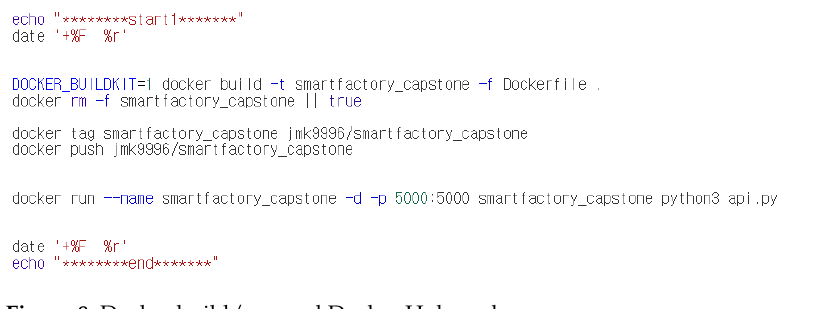
Figure 8. Docker build/run and Docker Hub push.